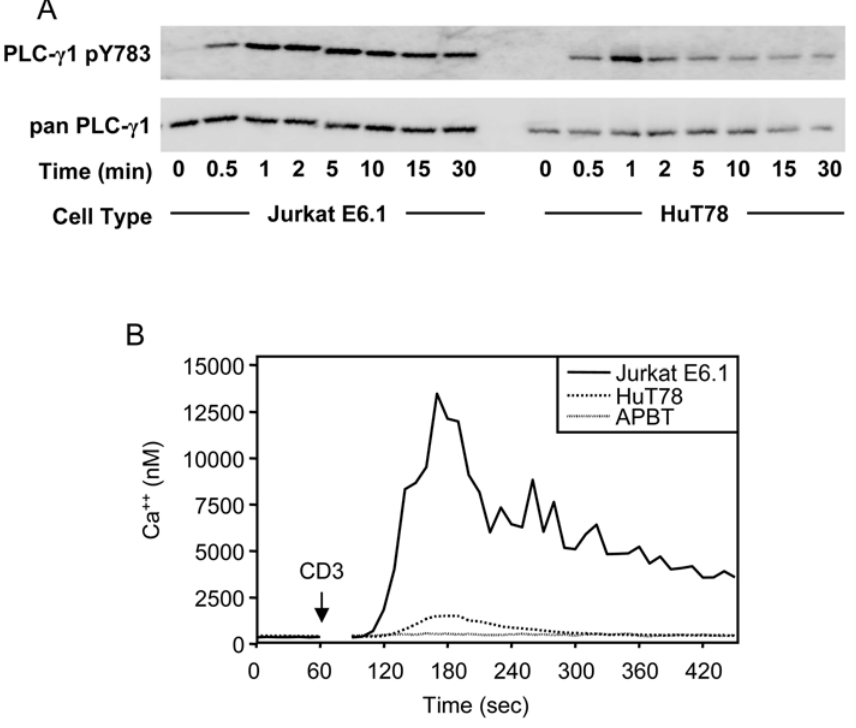
Figure 6. Jurkat E6.1 T cells have increased PLC c 1 function compared to HuT78 T cells and APBTs. (A) Jurkat E6.1 T cells and HuT78 T cells were stimulated over a 30 9 time course and the cellular proteins were separated by SDS-PAGE. The site-specific phosphorylation and expression of PLC c 1 and the expression of actin was assessed by immunoblotting using PLC c 1 pY783 (top) and pan-PLC c 1 (bottom) antibodies. (B) TCR-induced calcium flux was measured quantitatively as described above. Traces for Jurkat E6.1 T cells, HuT78 T cells and APBTs are